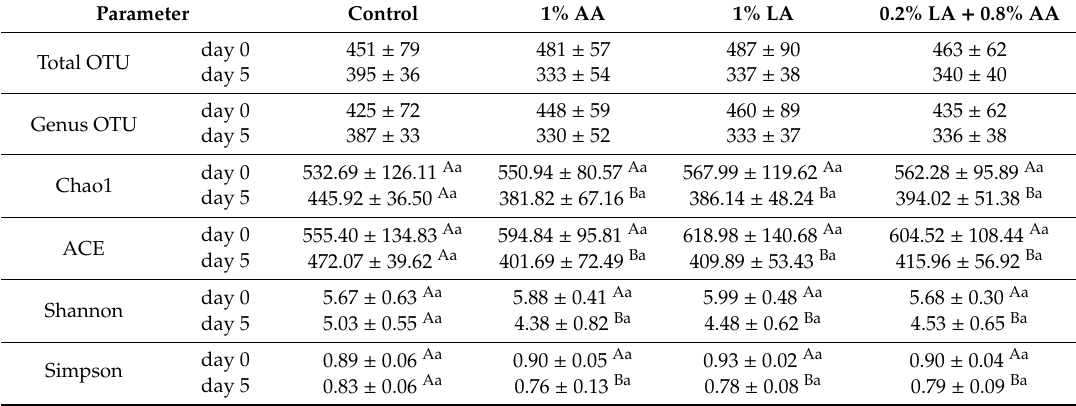
Table 2. Biodiversity estimator and operational taxonomic unit (OTU) numbers after